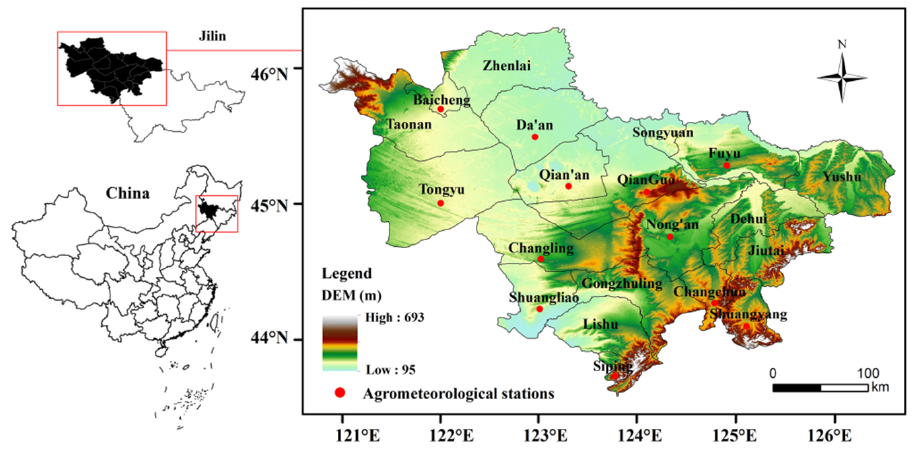
Figure 2. Location of the study area.